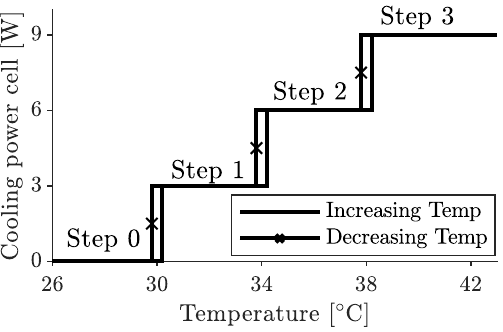
Figure 3. Overview of stepwise cooling system regulation with a hysteresis of 0.3K for decreasing and increasing